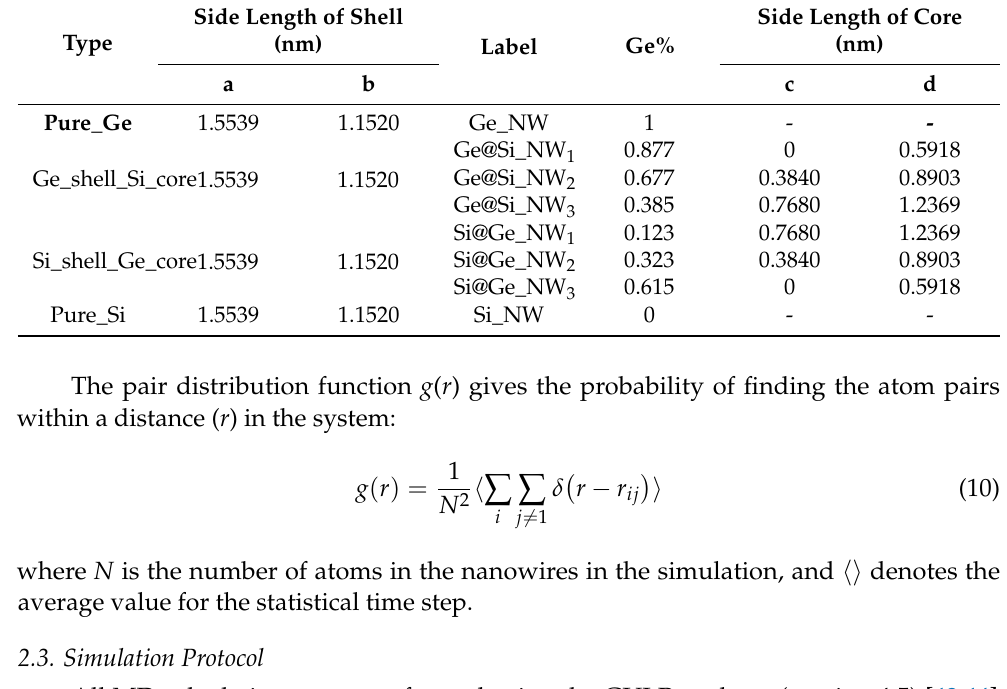
Table 2. The structural parameters of Ge@Si and Si@Ge nanowires with different core–shell ratios. Side Length of Type